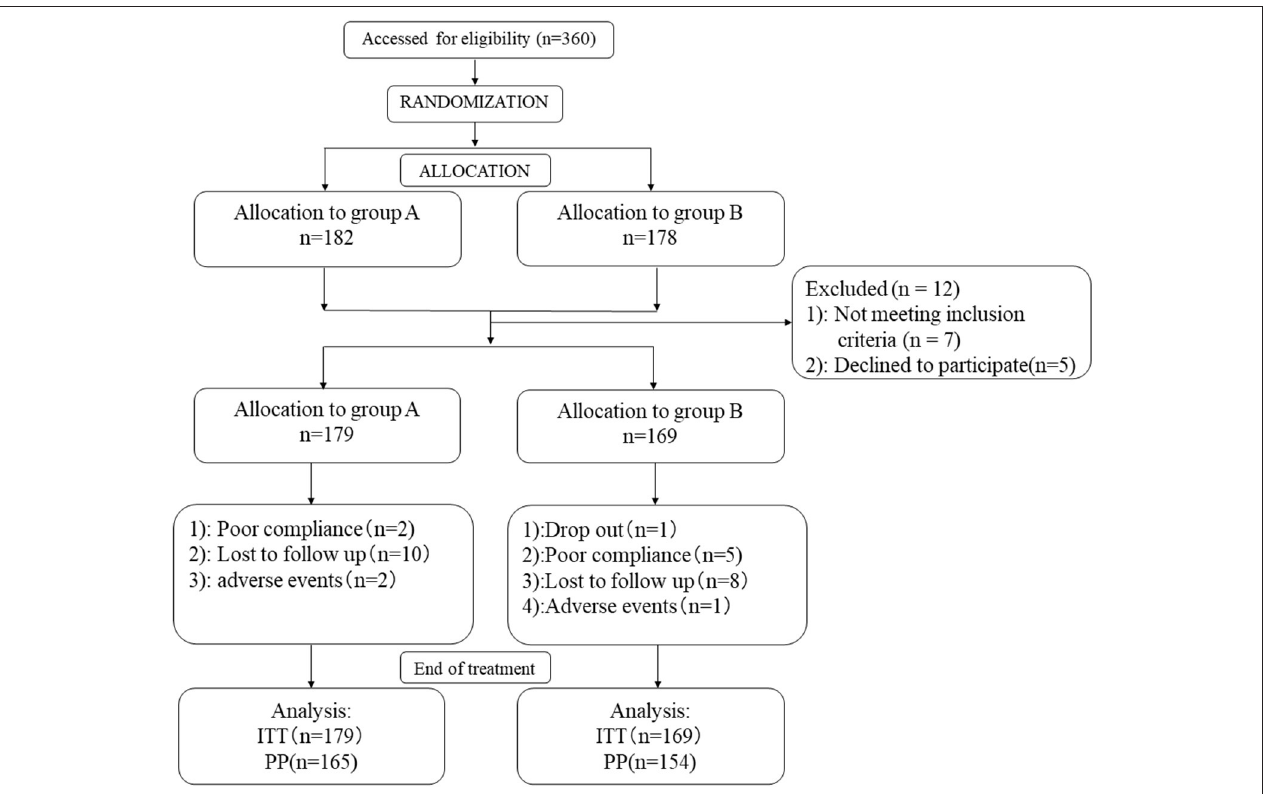
FIGURE 2 | Profile of the study